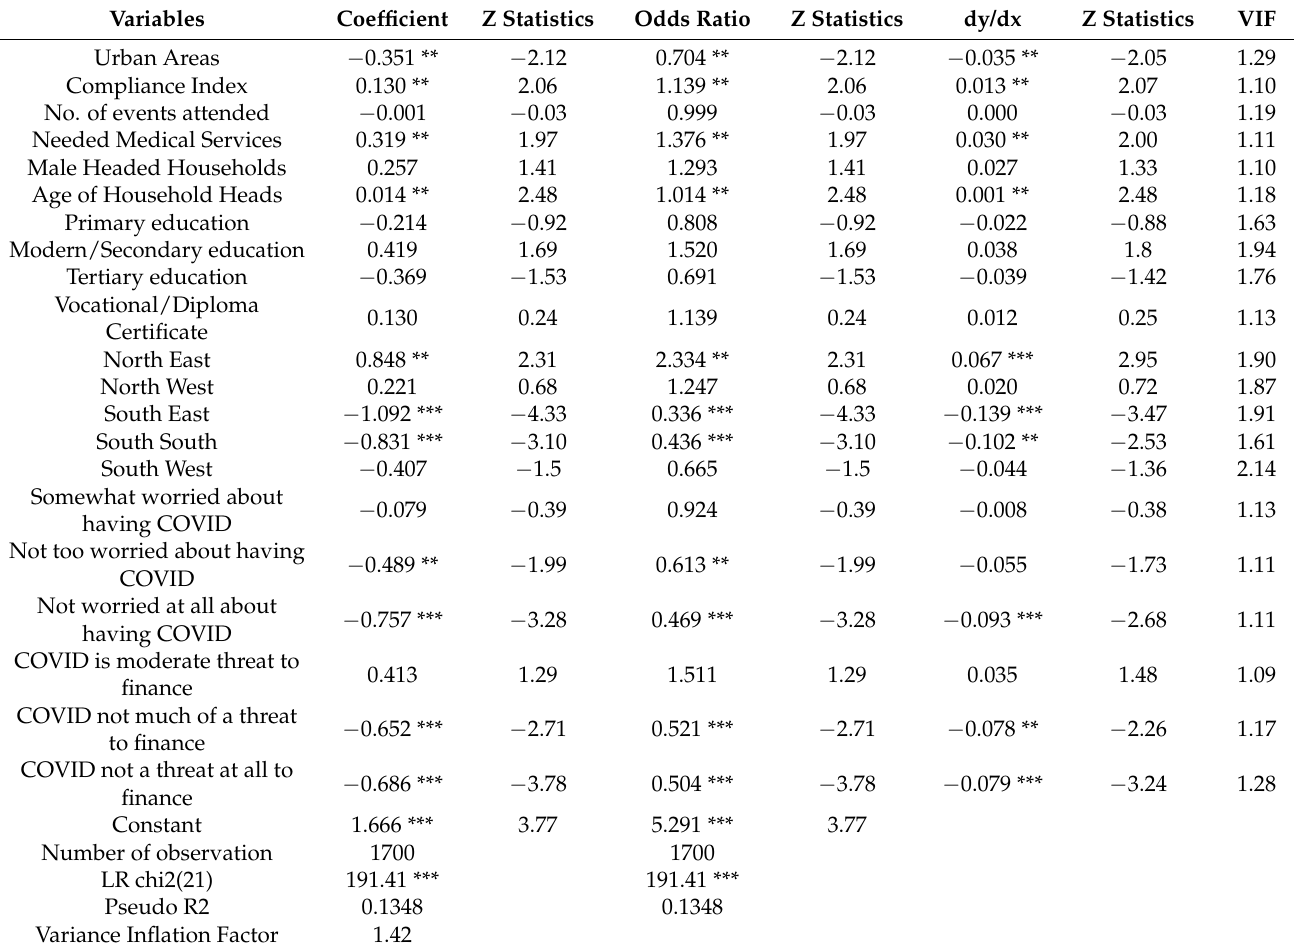
Table 4. Logit Regression Results of the Determinants of Willingness to Take COVID-19